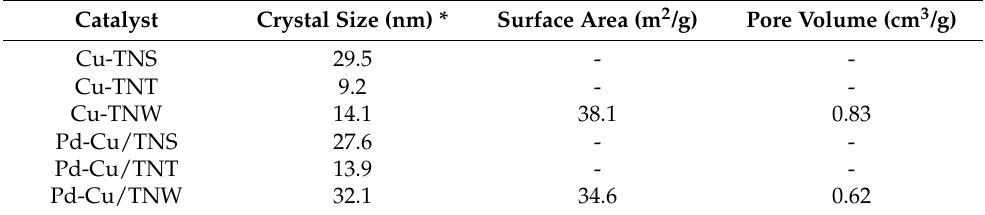
Table 1. Textural properties along with crystallite size of different prepared catalysts of this study.